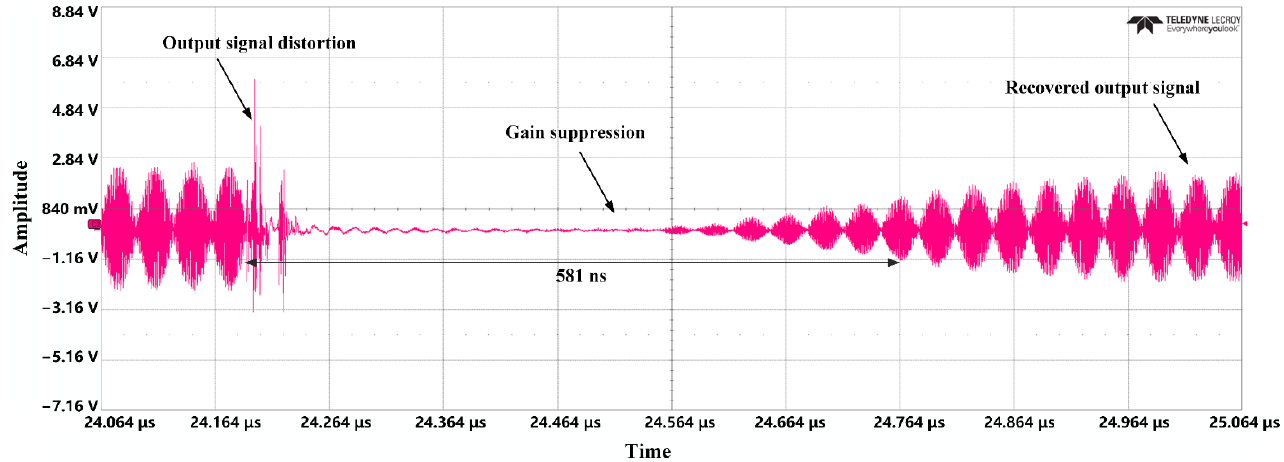
Figure 15. Effect experiment results.